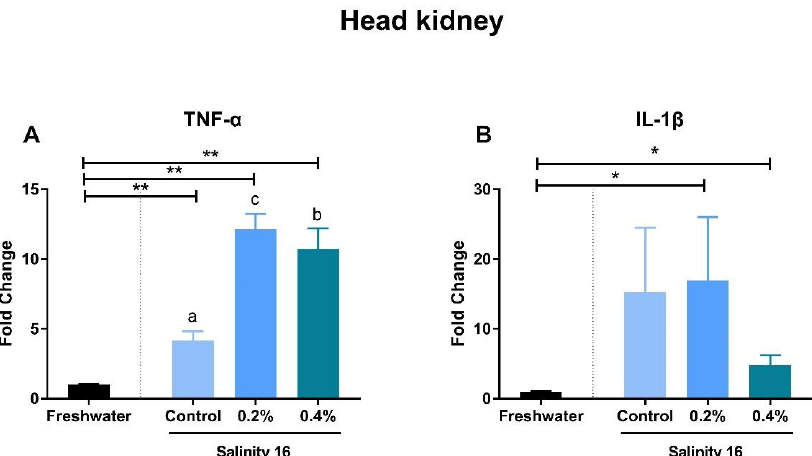
Figure 4. The gene expression of TNF- α ( A ) and IL-1 β ( B ) in the head kidney of O. niloticus fed diets with β -glucan in freshwater and brackish water. A single asterisk (*) indicates a significant difference ( p < 0.05), and two asterisks (**) indicate an extremely-significant difference ( p < 0.01). Different letters with a–c indicated significant differences among three treatments in 16 salinity water ( p < 0.05).